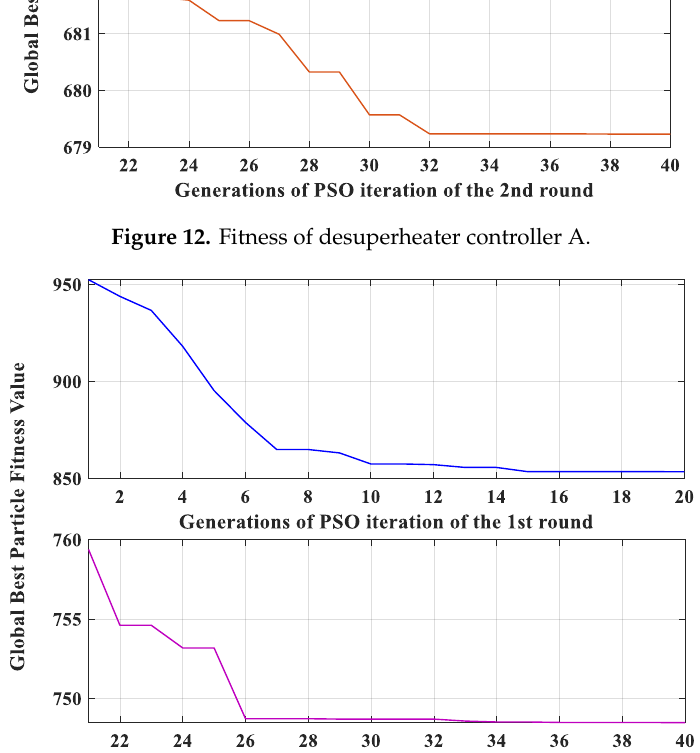
Figure 13. Fitness of desuperheater controller B .